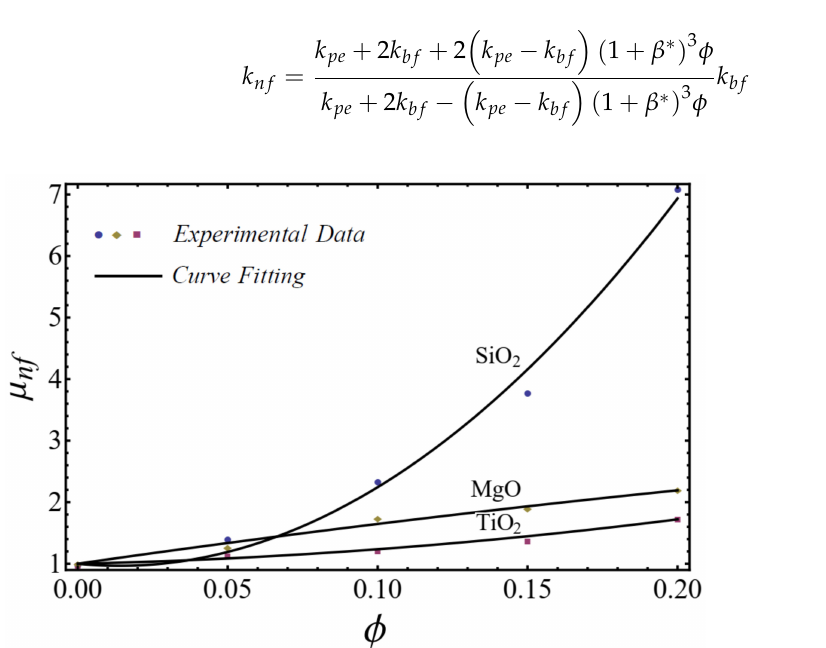
Figure 5. Curve fitting with experimental data for consistency index by using Equation (2).